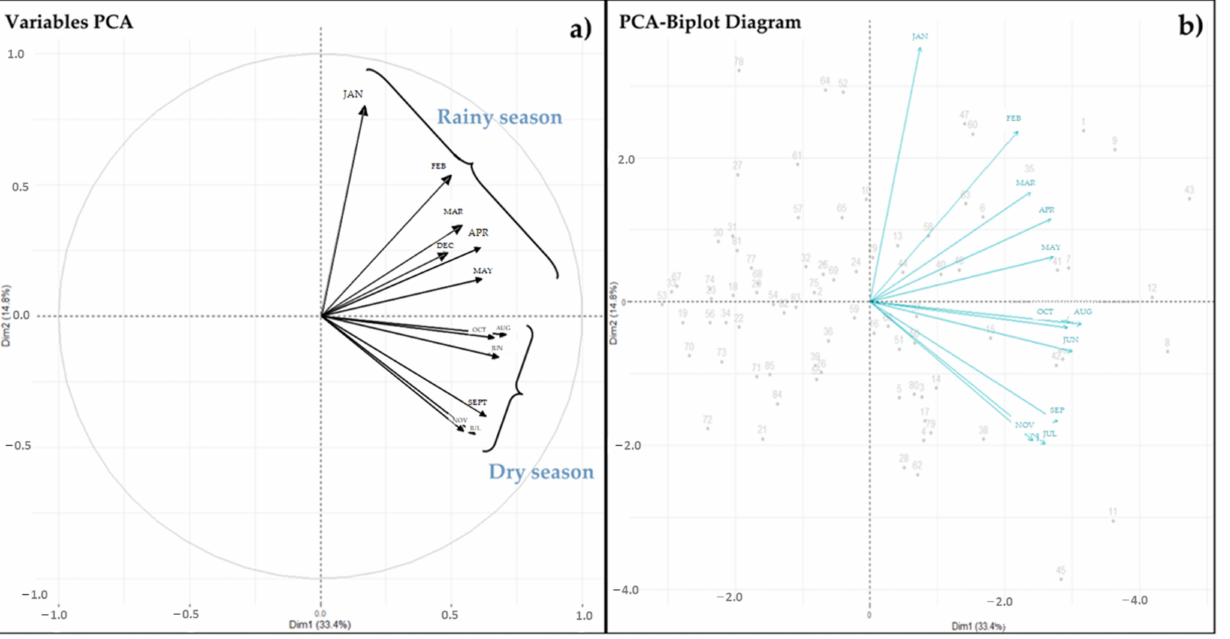
Figure 13. PCA results, used to classify precipitation by month. ( a ) PCA variables and ( b ) PCA